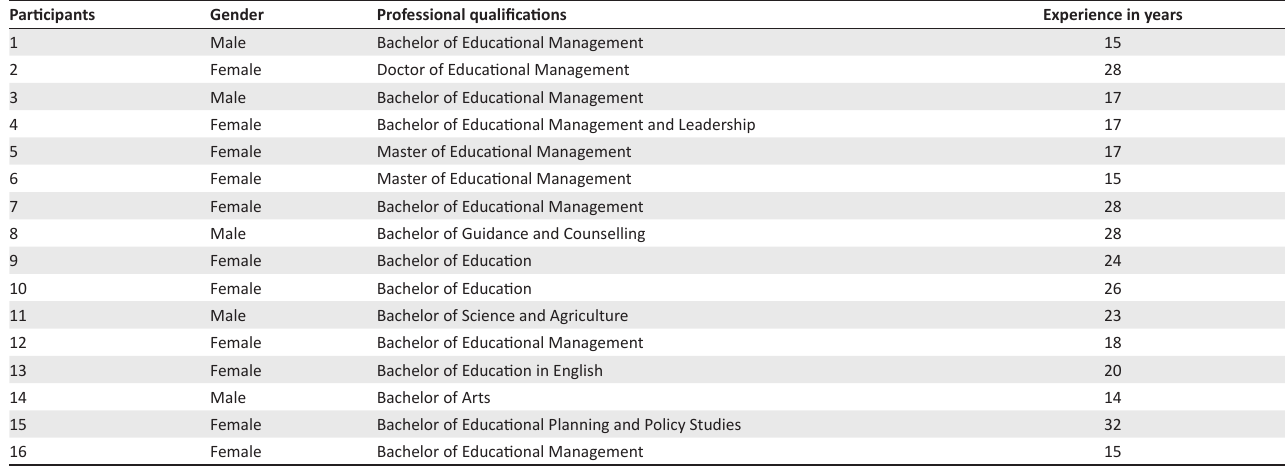
TABLE 1: Biographic data of participants. Participants